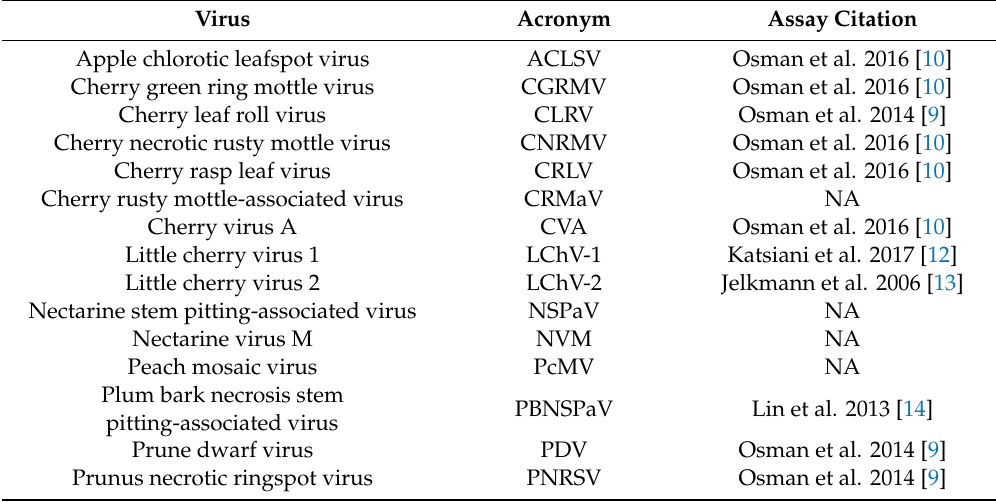
Table 1. Prunus -infecting viruses included in this study and currently available real-time RT-PCR assays. Virus Acronym Assay Citation Apple chlorotic leafspot virus ACLSV Osman et al. 2016 [10] Cherry green ring mottle virus CGRMV Osman et al. 2016 [10] Cherry leaf roll virus CLRV Osman et al. 2014 [9] Cherry necrotic rusty mottle virus CNRMV Osman et al. 2016 [10] Cherry rasp leaf virus CRLV Osman et al. 2016 [10] Cherry rusty mottle-associated virus CRMaV NA Cherry virus A CVA Osman et al. 2016 [10] Little cherry virus 1 LChV-1 Katsiani et al. 2017 [12] Little cherry virus 2 LChV-2 Jelkmann et al. 2006 [13] Nectarine stem pitting-associated virus NSPaV NA Nectarine virus M NVM NA Peach mosaic virus PcMV NA Plum bark necrosis stem PBNSPaV Lin et al. 2013 [14] pitting-associated virus Prune dwarf virus PDV Osman et al. 2014 [9] Prunus necrotic ringspot virus PNRSV Osman et al. 2014 [9] Not available assay